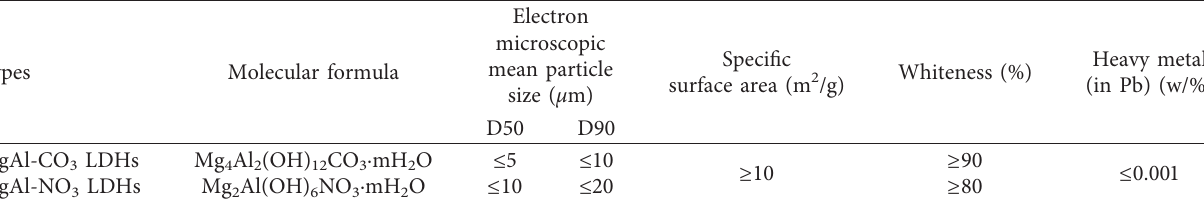
Table 3: Main technical indexes of